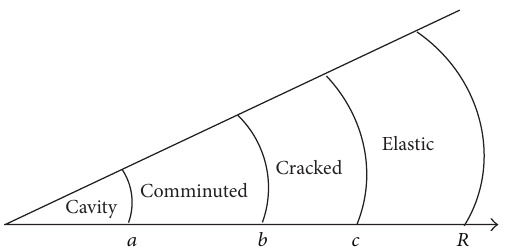
Figure 6: The destruction and deformation of target material in